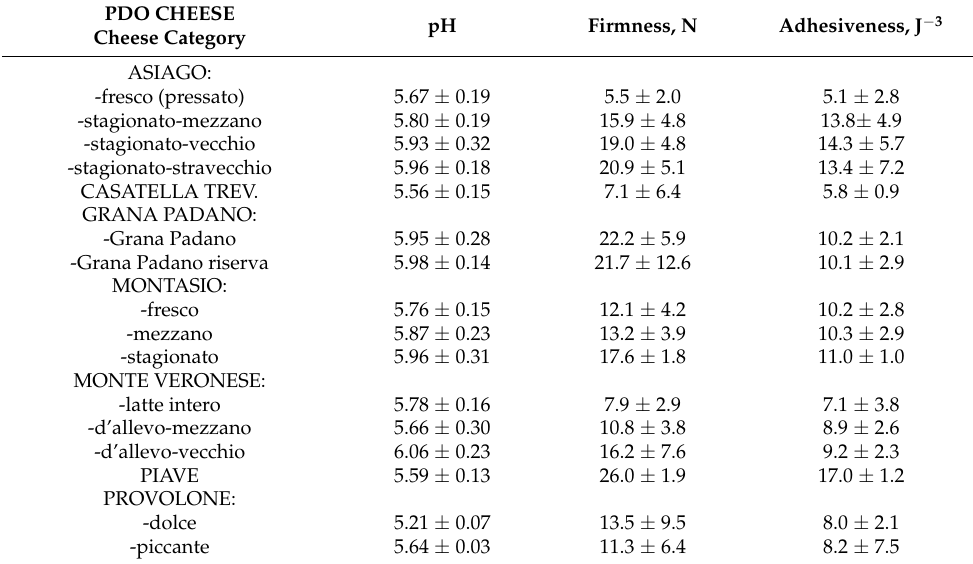
Table 9. Acidity and textural traits of cheeses with EU Protected Designation of Origin (PDO) status (averages and standard deviations by cheese category).